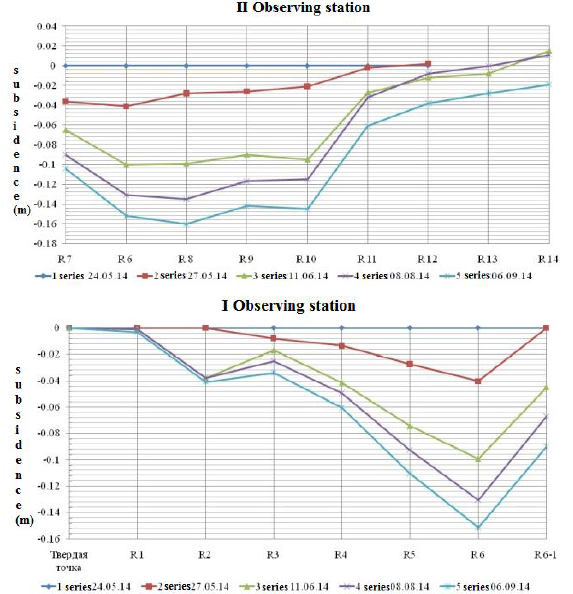
Figure 3. Graphical representation of the earth surface subsidence profile lines as a result of levelling